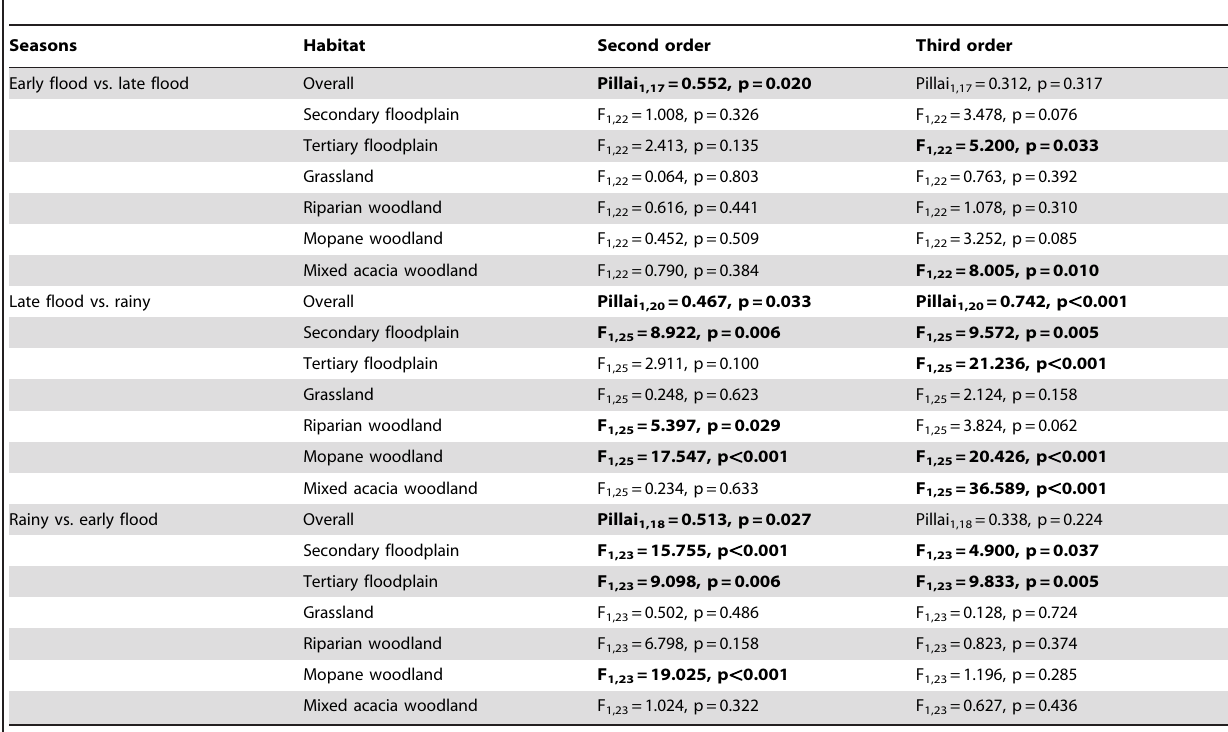
Table 5. Results from MANOVAs comparing second and third order habitat selection ratios in different seasons.